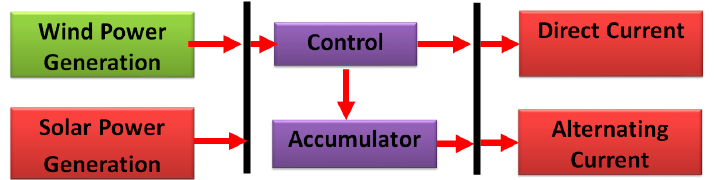
Figure 4. Wind energy and solar energy complementary intelligent system diagram.